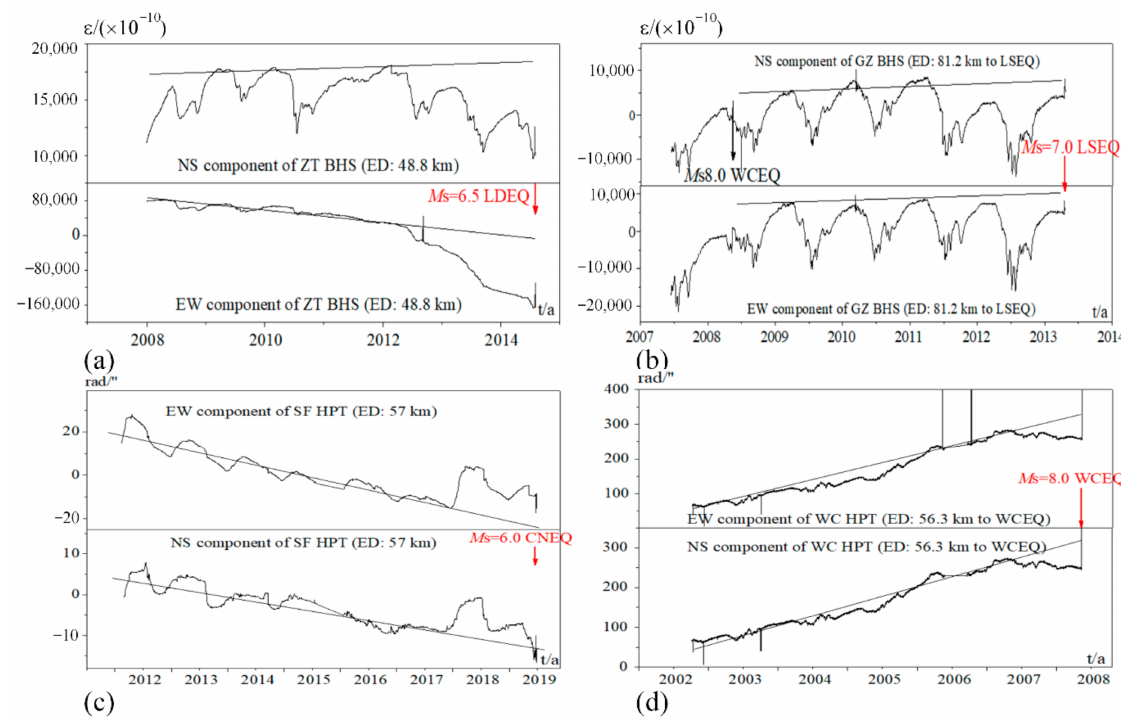
Figure 9. The geodetic time series observed near the epicenters of LDEQ ( a ), LSEQ ( b ), CNEQ ( c ), and WCEQ ( d ). ( a ) The NS and EW components of the ZT BHS, ( b ) the NS and EW components of the GZ BHS, ( c ) the EW and NS components of the SF HPT, ( d ) the EW and NS components of the WC HPT. The resolutions of the probes are also shown in Table 2.